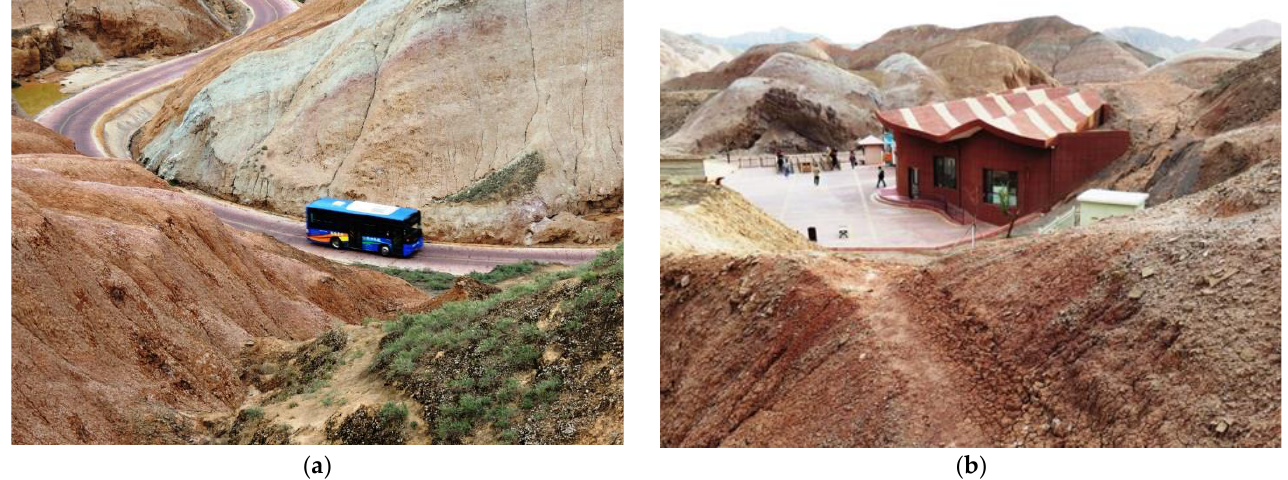
Figure 7. ( a ) The road which enters the Danxia of Linze (credit Fabio Fratini); ( b ) a bus stop in the Danxia of Linze (credit Loredana Luvidi) .